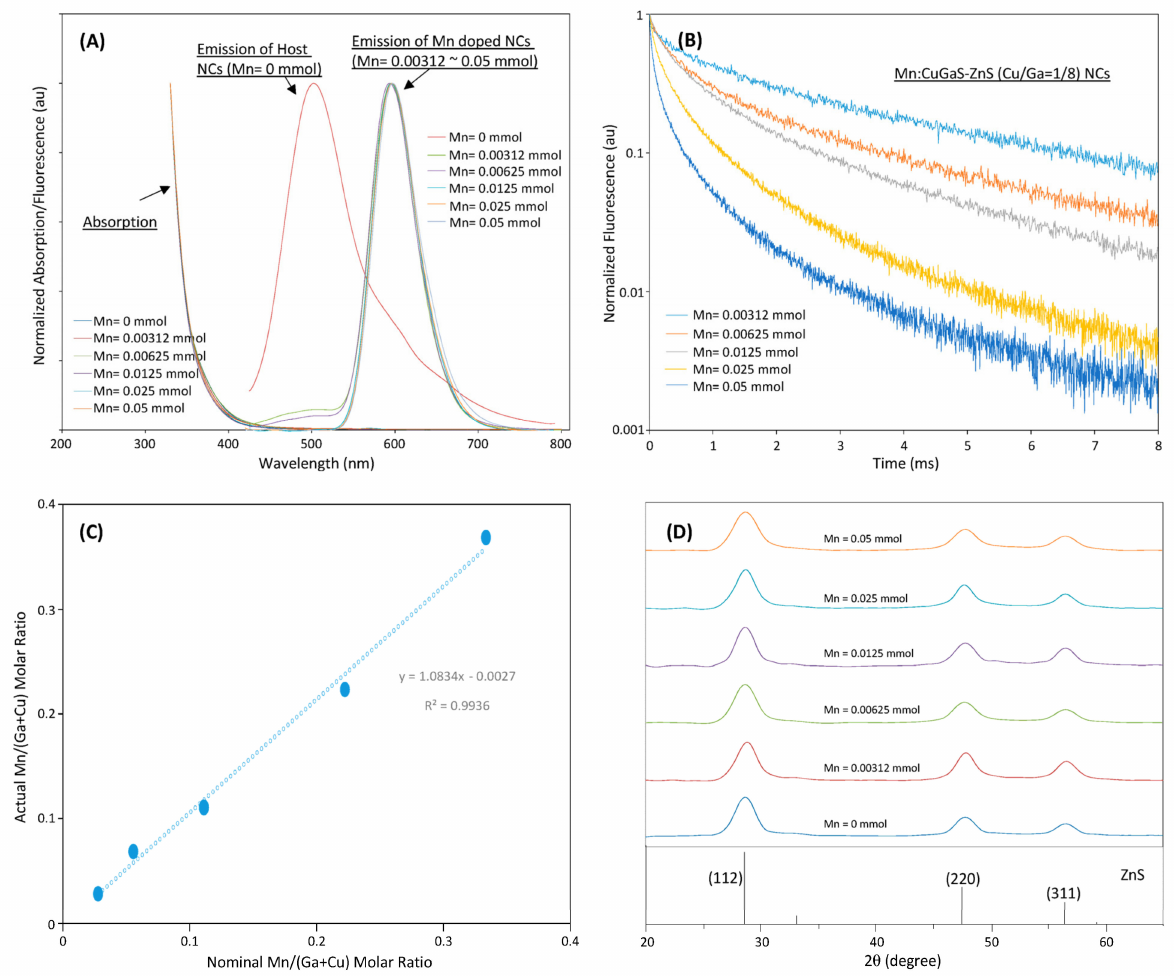
Figure 4. ( A ) Fluorescence and absorption spectra of CuGaS-ZnS (Cu/Ga = 1/8) NCs and Mn:CuGaS- ZnS (Cu/Ga = 1/8) NCs with a wide Mn-concentration range in synthesis. ( B ) Fluorescence decays of Mn:CuGaS-ZnS (Cu/Ga = 1/8) NCs at their peak wavelengths with different Mn concentrations in synthesis. ( C ) ICP-based actual Mn/(Ga + Cu) molar ratios of Mn:CuGaS-ZnS (Cu/Ga =1/8) NCs with a series of Mn concentrations in synthesis. ( D ) XRD patterns of Mn:CuGaS-ZnS (Cu/Ga = 1/8, Mn = 0.0125 mmol) NCs with different Mn concentrations in